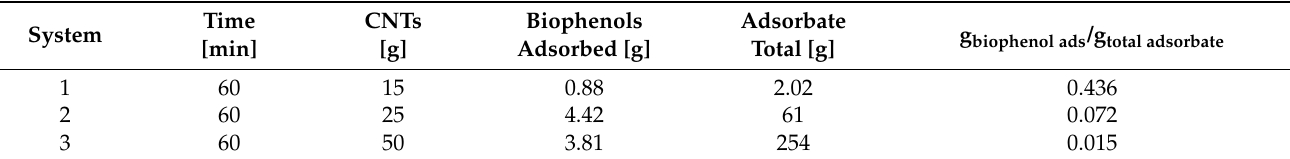
Table 2. Grams of carbon nanotubes to be used, g biophenols adsorbed , g adsorbate total and the ratio g biophenol ads /g total adsorbate , assuming a treatment of 1 L of OVWs and operating with the conditions relating to systems 1, 2 and 3 at 60 min as contact